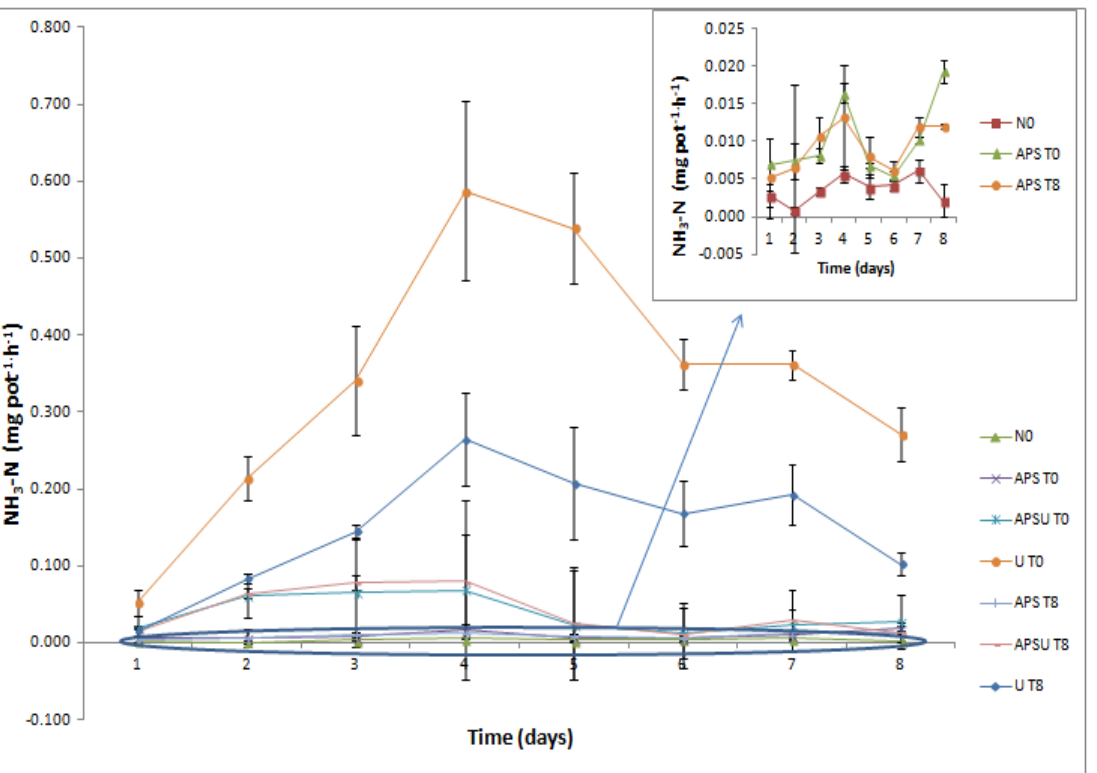
Figure 4. NH 3 –N daily emission rates (mg pot −1 h −1 ). Error bars represent the standard error values (mean, n = 3). U: Urea; APS: Acidified pig slurry; APSU: U + APS; N0: Control; T0: Fertilizer applied right after sowing; T8: Fertilizer applied 8 days after sowing.